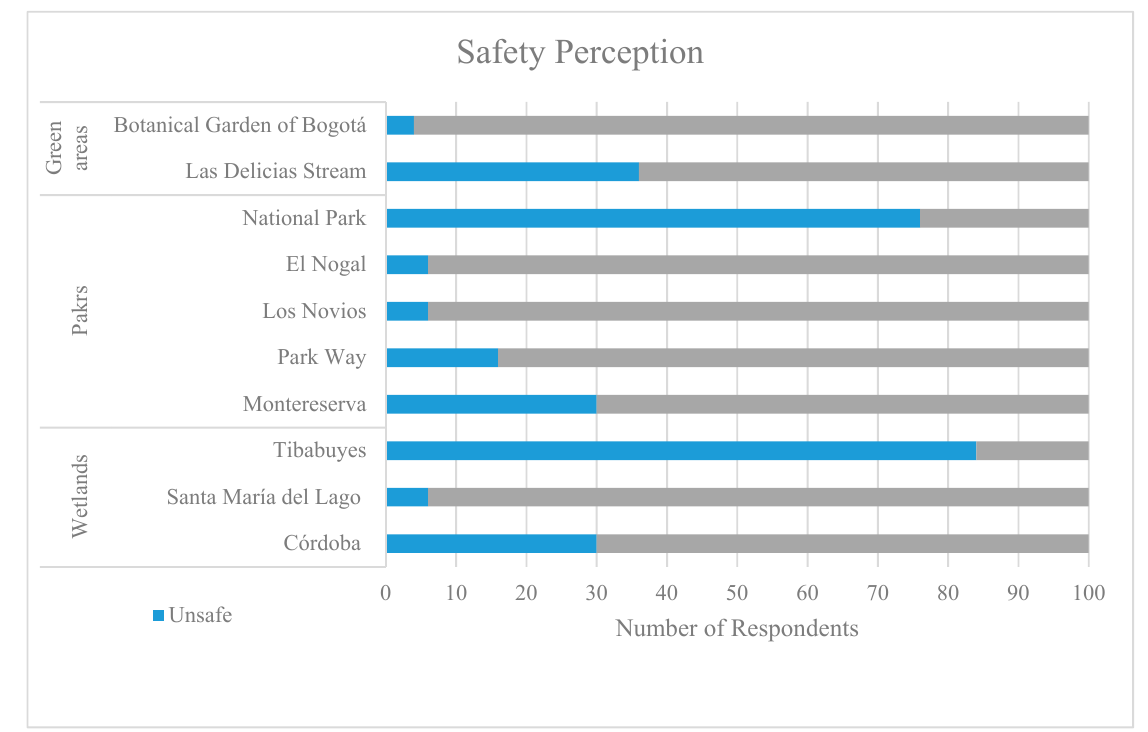
Figure 2. Number of responses towards the perception of levels of a cost in the form of high crime (Unsafe) and low crime (Safe) in 10 different green areas and wetlands in the El Salitre sub-watershed in Bogotá, Colombia.